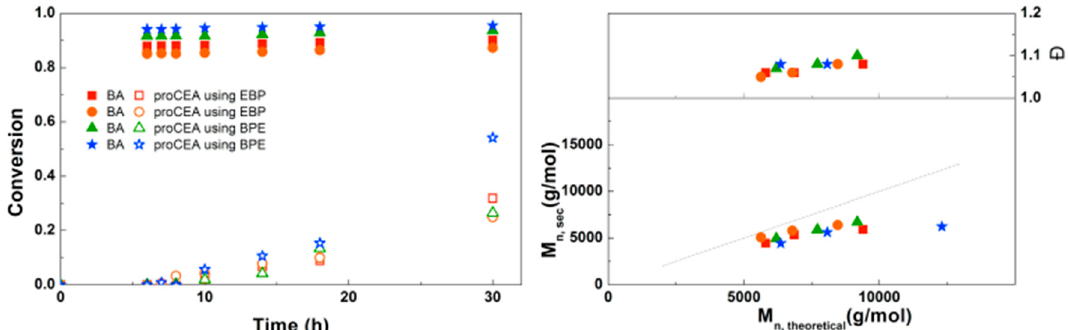
Figure 11. ( Left ): conversion versus time plot for Cu(0)-mediated one-pot block copolymerization of BA and proCEA using [BA]:[proCEA]:[EBP]:[Me 6 TREN]:[CuBr 2 ] = 50:50:1:0.15:0.1 and [BA]:[proCEA]:[BPE]:[Me 6 TREN]:[CuBr 2 ] = 50:50:1:0.3:0.2, 3.0 M in DMF at 25 ◦ C and 12.5 mm 2 /mL Cu(0) wire. A 3.0 M solution of proCEA in DMF was added after 6 h reaction time. ( Right ):